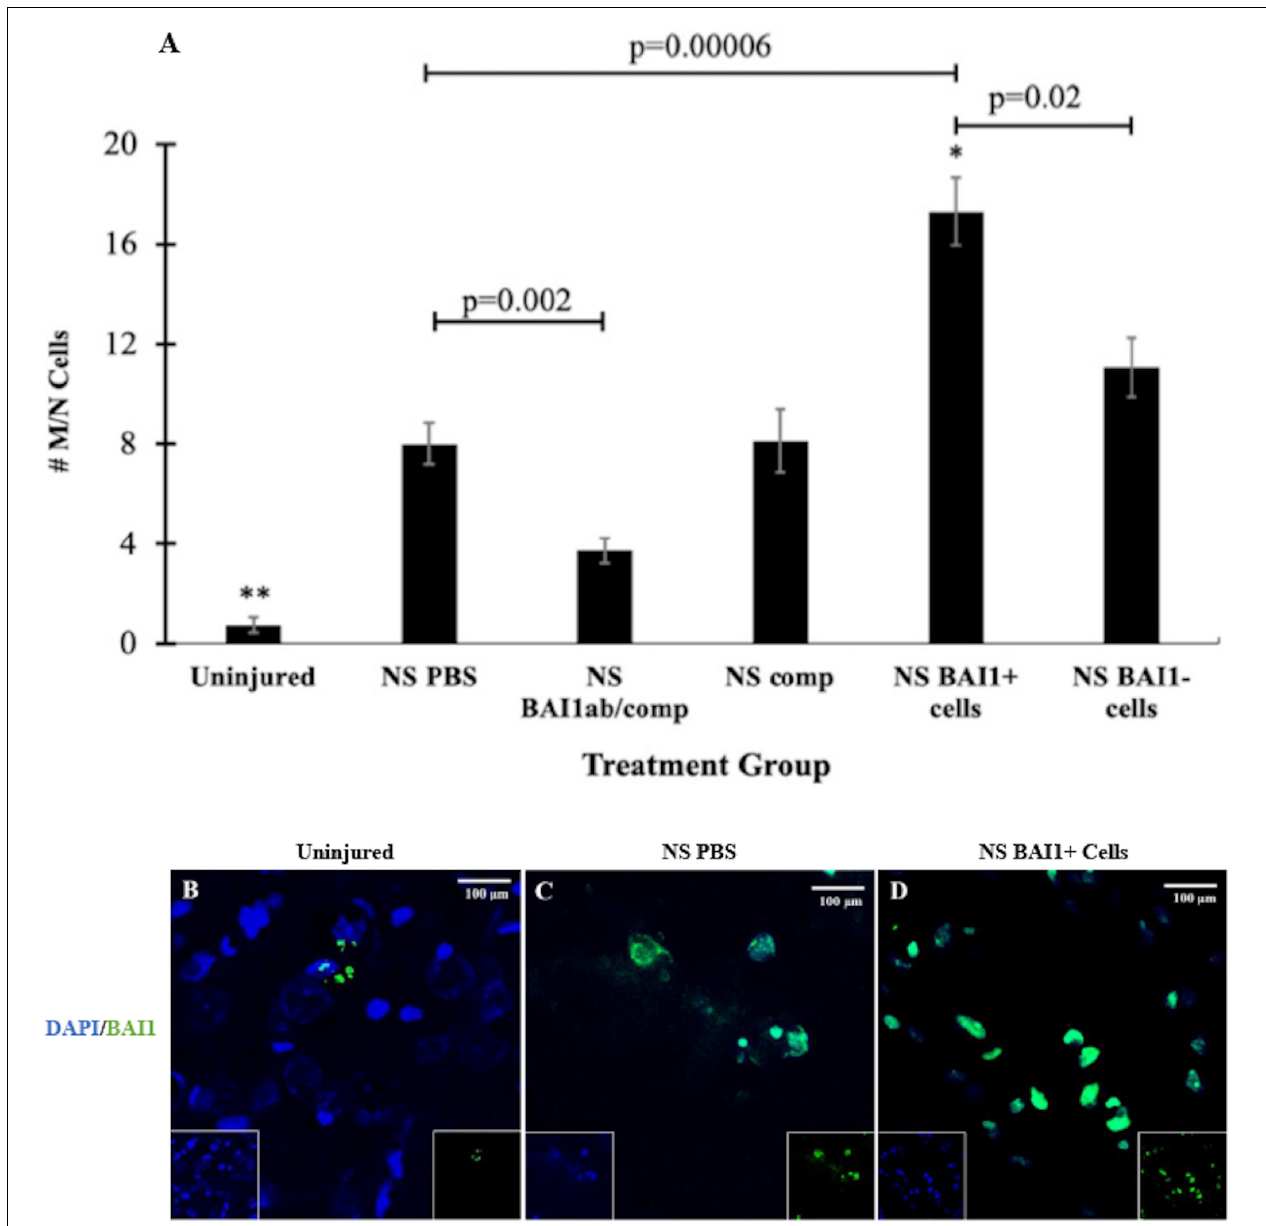
FIGURE 2 | Comparison of the number of Myo/Nog cells before and after NS injury and with depletion or addition of BAI1+ cells. Six tissue sections from 3 to 6 animals per treatment group were labeled with the BAI1 mAb (green in B–D ). Nuclei were stained with DAPI (blue in B–D ). BAI1+ cells were counted within a 1 mm area lateral to NS tract or in a similar area in the uninjured brain. The results are the means ± SEM 24 h after NS with injection of PBS, the BAI1 mAb and complement (BAI1ab/comp), complement alone (comp), BAI1+ cells or BAI1– cells (A) . NS injury significantly increased the number of Myo/Nog cells compared to a similar region in the uninjured brain ( ∗∗ p = 0.00001). Treatment with the BAI1 mAb and complement (abBAI1/comp) significantly reduced the number of Myo/Nog cells compared to NS with PBS ( p = 0.002), BAI1+ cells ( p = 0.00001), BAI1– cells ( p = 0.0002), or comp alone ( p = 0.04). Significantly more Myo/Nog cells were present in brains injected with Myo/Nog cells than the other groups ( ∗ p < 0.05). Myo/Nog cells were most prevalent after injection of exogenous BAI1+ cells ( D ; p = 0.00006). Unmerged images are shown as insets at the bottom of the photographs of merged images. Panels (B–D) are photographs of BAI1 and DAPI